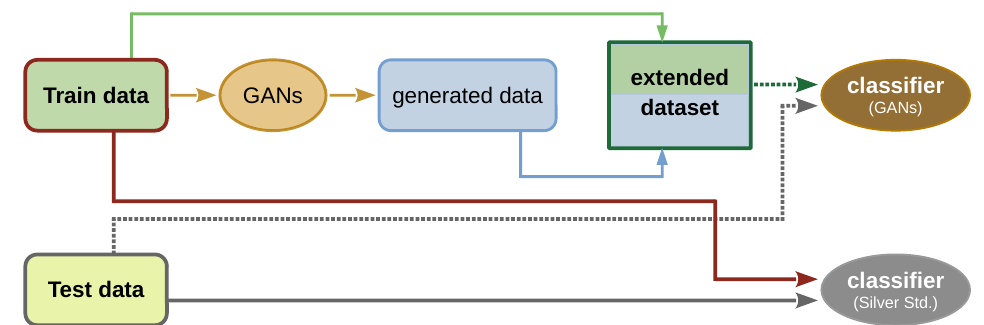
Figure 2. Schematic overview of the evaluation of data generated by GAN variants: Data are divided into Train and Test, the GAN models generate synthetic data based on the Train data; Train and generated data are combined into an extended dataset. The classifier is trained once with only the original Train data (Silver Standard), and then using the extended dataset (including generated data) corresponding to each GAN variants. The classifiers are in the end evaluated with Test